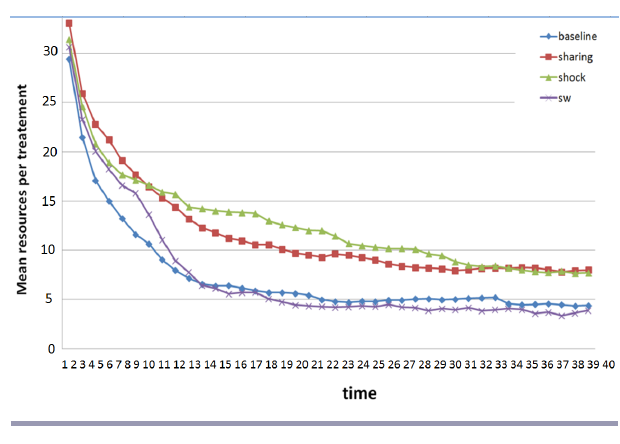
Fig. 2 . Mean resources per treatment.